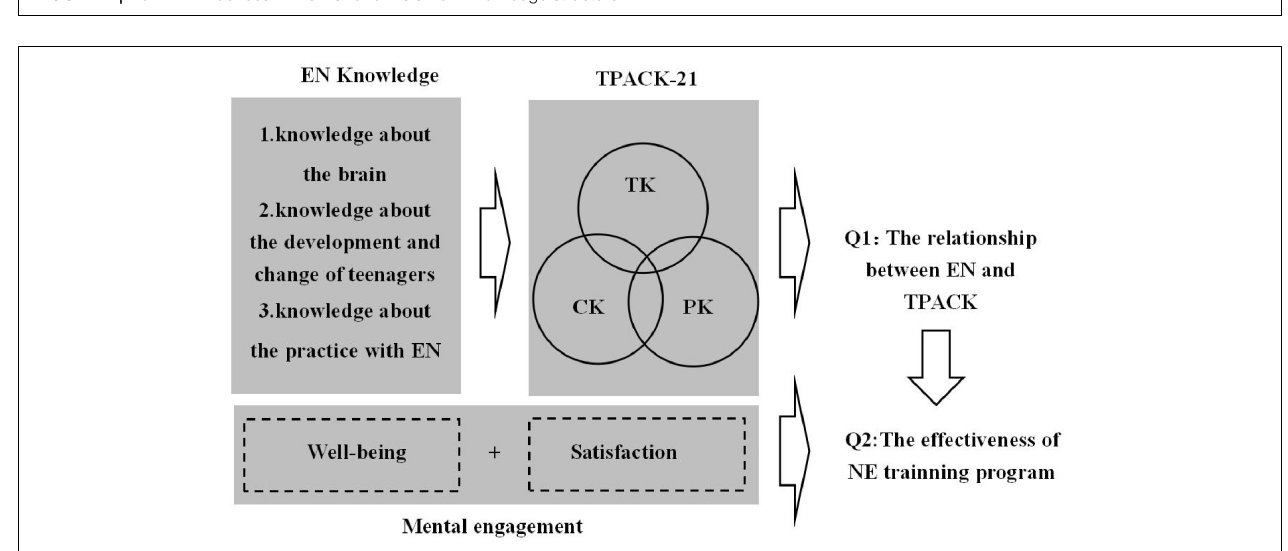
FIGURE 1 | How EN influences TPACK and forms a new knowledge structure.